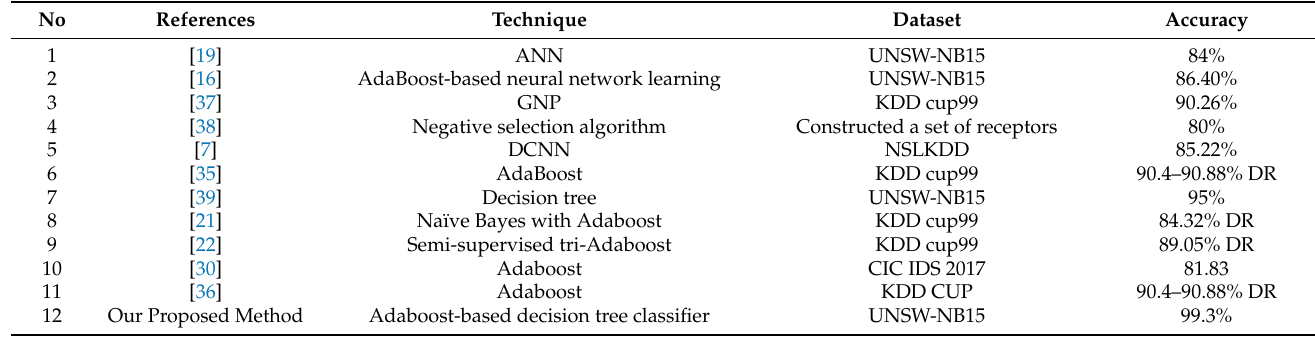
Table 6. Comparison with existing